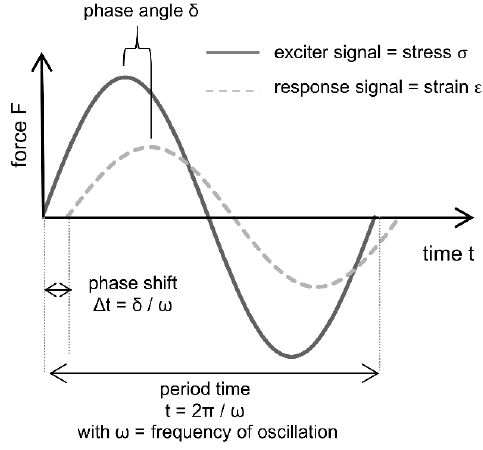
Figure 5. Wave function of exciter and response signal in DMA according to [18].